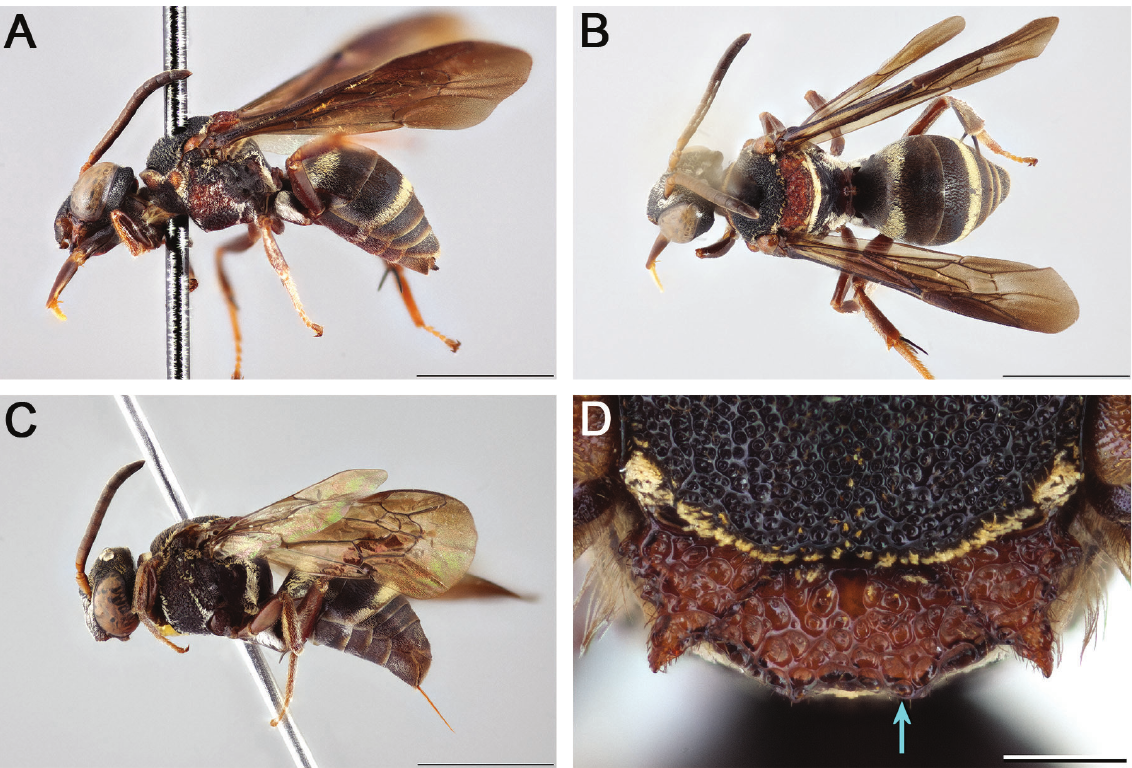
Fig. 16. Epeolus nomadiformis sp. nov., ♀♀. A – B . Holotype, (KUNHM SEMC1248290). A . Habitus, lateral view. B . Habitus, dorsal view. C – D . Paratype, (CNC 754064). C . Habitus, lateral view. D . Axillae and mesoscutellum, dorsal view (blue arrow indicates one of two posteriorly directed tooth-like projections of mesoscutellum). Scale bars: A–C = 3 mm; D = 0.5